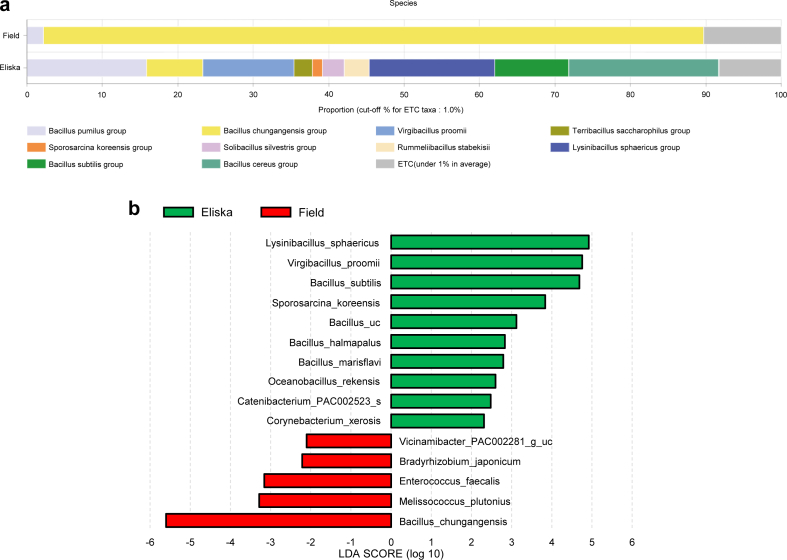
(a) The distribution of bacterial taxa at the species level in tick samples collected from Eliska's body and from the field. Each bar depicts the mean relative abundance value of independent replicates. Species comprising more than 1% of reads are shown. Each bar depicts the mean relative abundance value of independent replicates (n = 4 ticks collected from the field; n = 3 ticks collected from Eliska's body). (b) LEfSe analysis of differentially abundant bacterial taxa between ticks collected from Eliska's body and ticks collected from the field. Only taxa meeting an LDA significant threshold of >2 are shown.